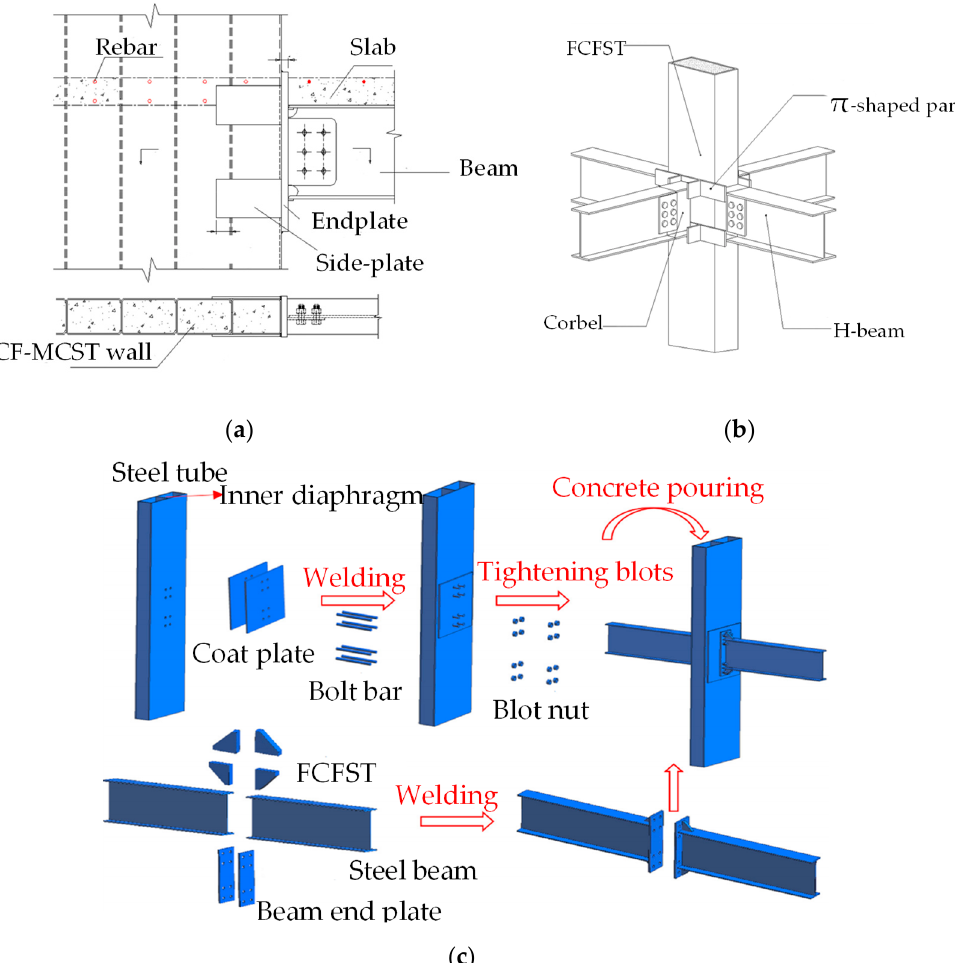
Figure 4. Previously developed connections for a flat CFST column: ( a ) Connection with external stiffeners; ( b ) π -shaped joint; ( c ) Flat CFST column to steel beam joints with a stayed bolt.